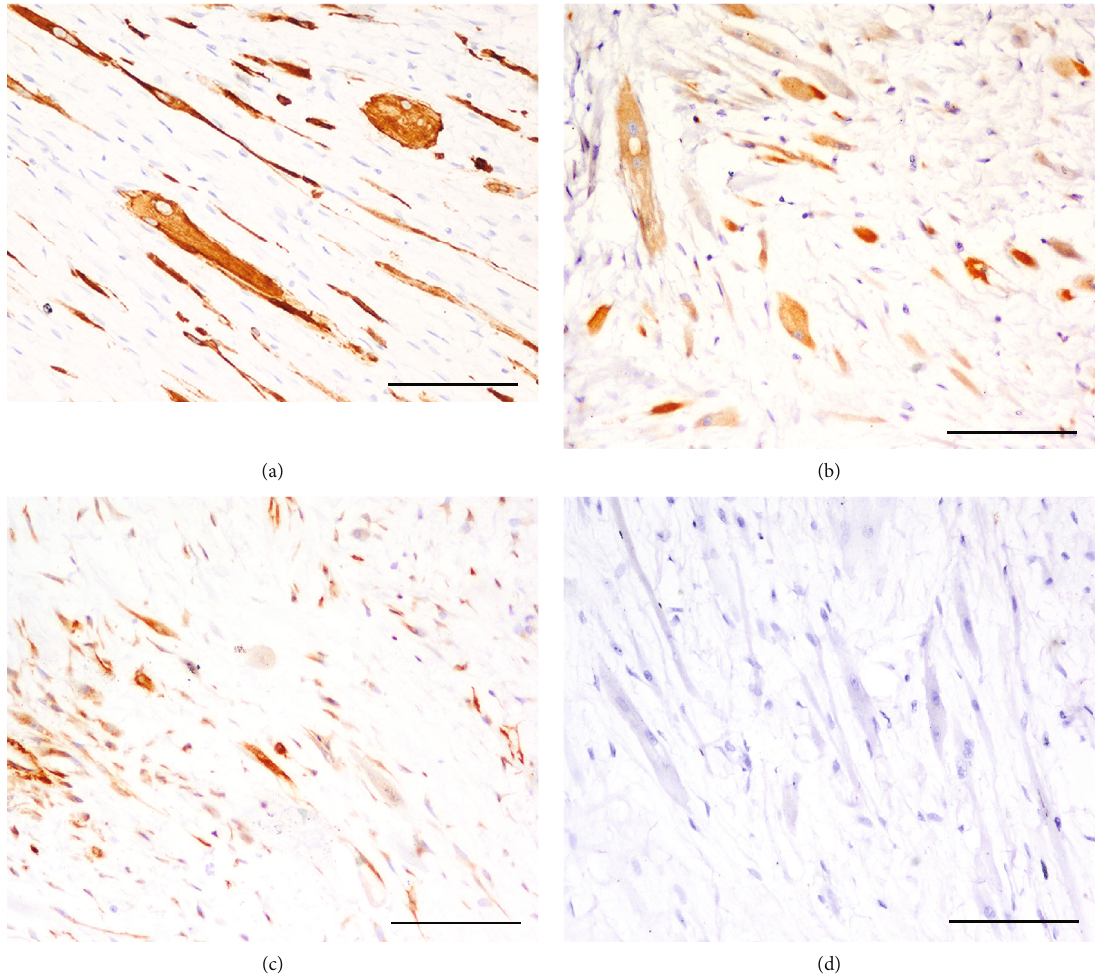
Figure 2: (a) Desmin expression of both thin elongated smooth muscle cells and large multinucleated striated muscle cells. IHC, 20x, scale bar 100 micron. (b) Calponin expression of both thin elongated smooth muscle cells and large multinucleated striated muscle cells, IHC, 20x, scale bar 100 micron. (c) Smooth muscle actin in elongated smooth muscle cells but not in the large striated muscle cells, IHC, 20x, scale bar 100 micron. (d) p63 negative in both smooth muscle and striated muscle cells, IHC, 20x, scale bar 100